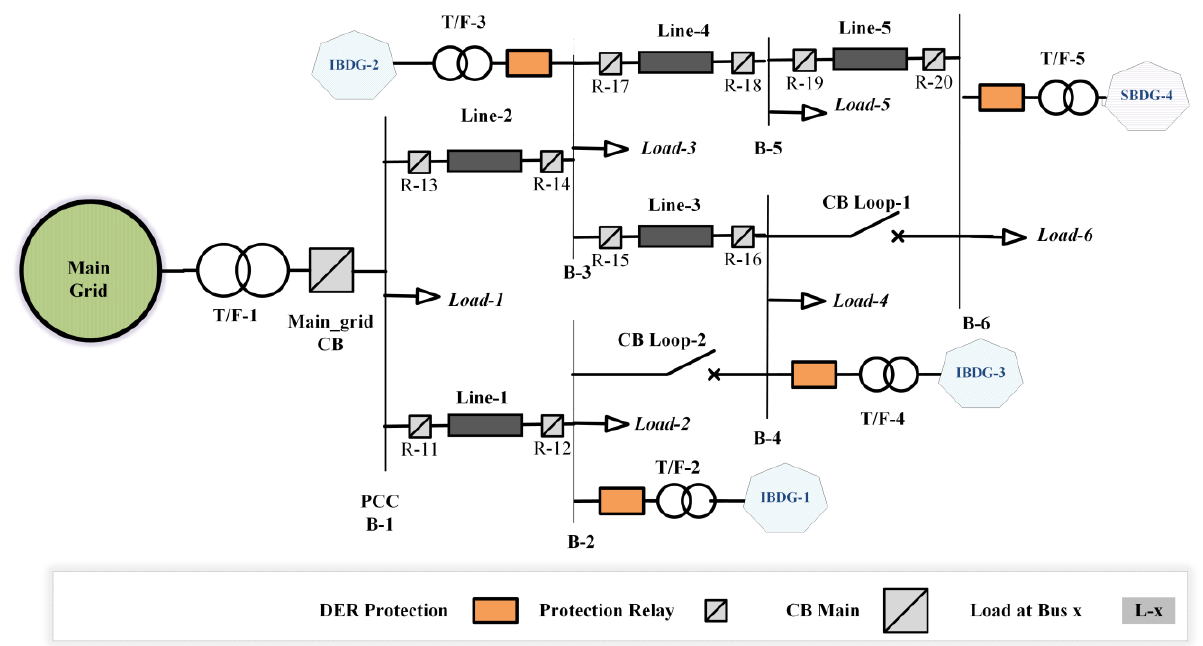
Figure 1. Standard International Electro-Technical Commission test bed.